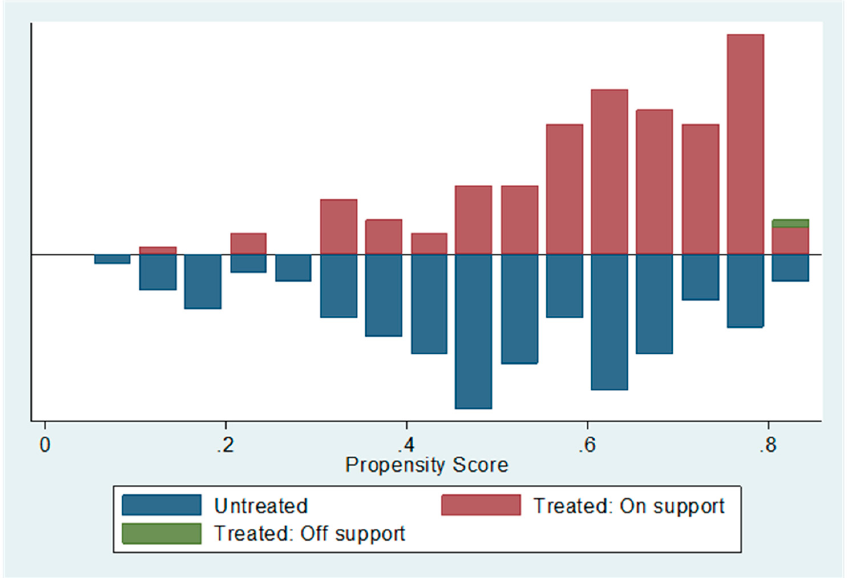
Figure 1. Propensity matching score.